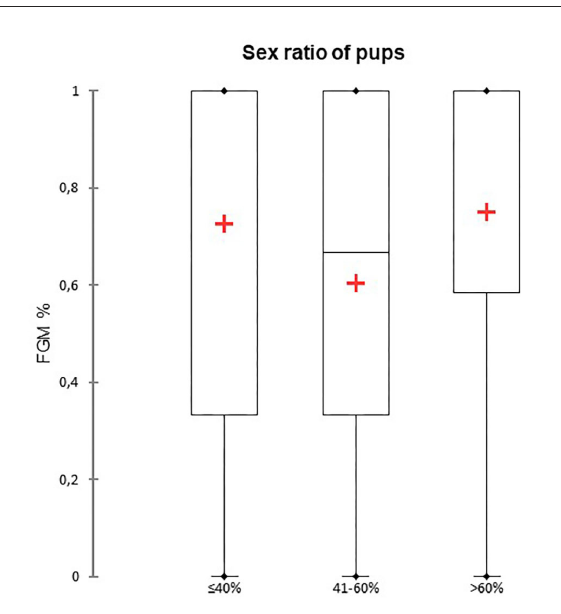
FIGURE4 The box plot reports the percentage of fetuses showing fetal gastrointestinal motility (FGM%) dependent on the sex ratio of pups. Sex ratios were divided into three different classes depending on the percentage of females: ≤ 40%, 41–60%, and > 60%. The mean is indicated as a red cross ( +